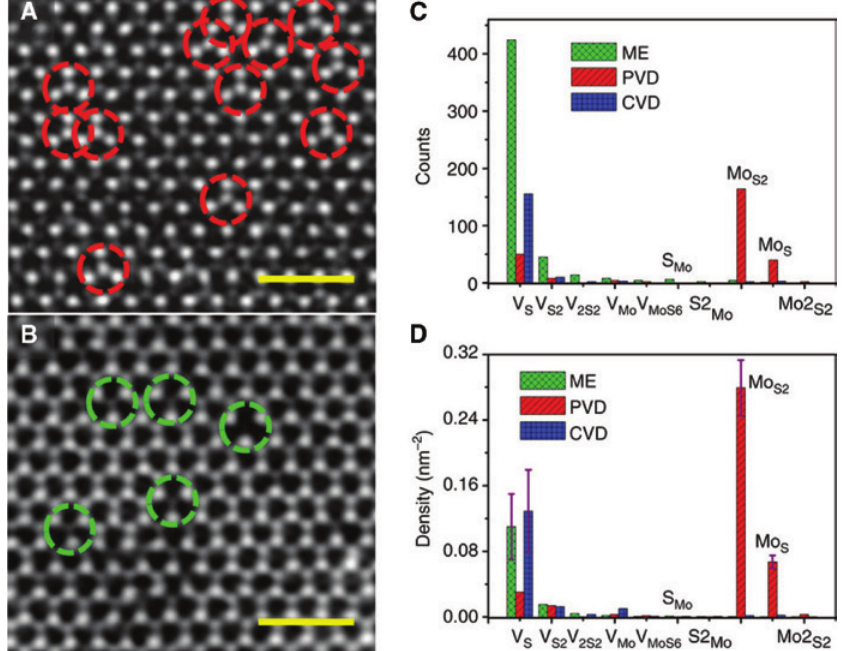
Figure 2: Growth related point defects, taken from Ref. [45]. (A) Antisite defects in PVD MoS observed for CVD sample. scale bar 1 nm. (C, D) Histogram of various point defects in PVD, CVD, and ME monolayers. ME data are in green, PVD data are in red, and CVD in